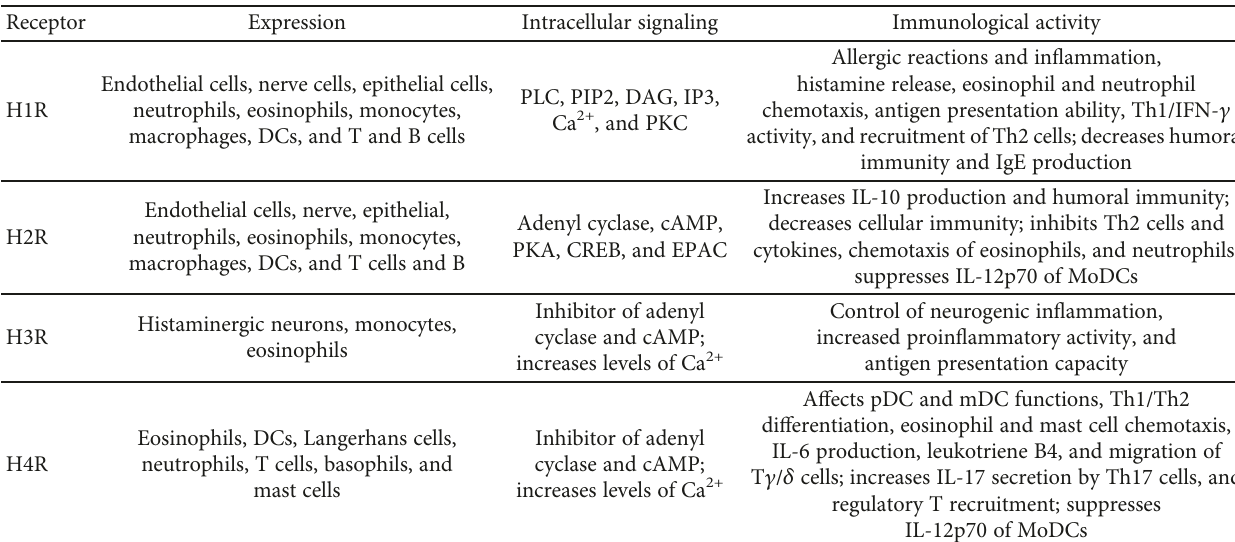
Figure 1: Intracellular activation cascades triggered by histamine receptors (HRs). The pleiotropic e ff ects of histamine are mediated by four histamine receptors: H1R, H2R, H3R, and H4R, which are G protein-coupled receptors. Signaling via H1R leads to activation of intracellular transcription factors, such as PLC (phospholipase C), IP3 (inositol triphosphate), PKC (protein kinase C), DAG (diacylglycerol), and Ca 2+ . H2R signaling acts through activation of adenylyl cyclase (AC), which increases cyclic adenosine monophosphate (cAMP) levels and activates protein kinase A (PKA), while H3R and H4R inhibit this cascade. Those intracellular signaling pathways culminate into protein phosphorylation and transcription of nuclear factor such as nuclear factor kappa B (NF- κ B), nuclear factor of activated T-cells (NFAT), cAMP response element binding protein (CREB), and activator protein 1 Table 1: Immunological functions mediated by histamine receptors signaling.